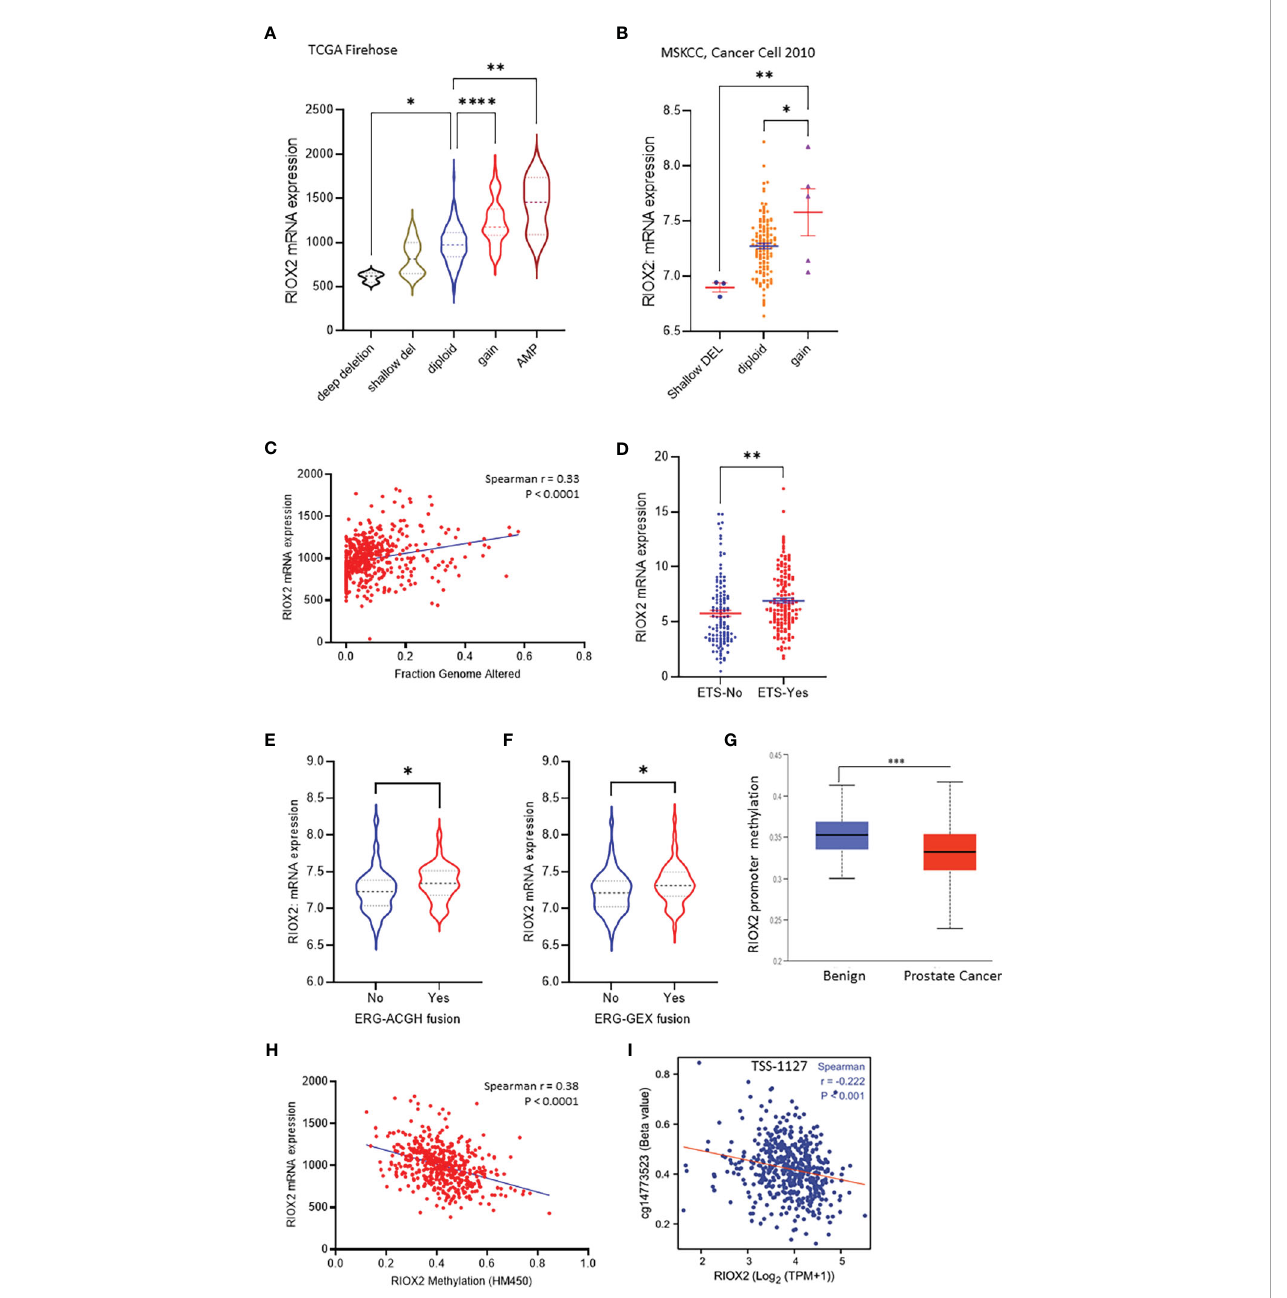
FIGURE 3 RIOX2 upregulation is associated with genetic alteration and promoter hypomethylation in prostate cancers. (A) RIOX2 mRNA expression was analyzed using the TCGA-PRAD RNA-seq dataset coupled with genetic copy number alterations. Case numbers in each group are as follows: deep deletion, 3; shallow deletion, 10; diploid, 430; gain, 45; ampli fi cation, 3. (B) RIOX2 mRNA expression was analyzed using the MSKCC RNA-seq dataset coupled with genetic copy number alterations. Each group ’ s case numbers are as follows: shallow deletion, 3; diploid, 118; gain, 5. (C) Spearman correlation analysis was performed using the TCGA-PRAD dataset between RIOX2 mRNA expression and Fraction Genomic Altered index. (D – F) RIOX2 mRNA expression levels in the TCGA-PRAD dataset were compared between groups with or without gene fusion features as indicated. The asterisk indicates a signi fi cant difference (Student t -test, *p < 0.05, **p < 0.01, ***p<0.001, ****p < 0.0001). (G) Promoter methylation levels of RIOX2 gene promoter were compared between benign and malignant prostate tissues using the UALCAN platform. (H, I) Spearman correlation analysis was conducted using the TCGA-PRAD RNA-seq and DNA methylation HM450